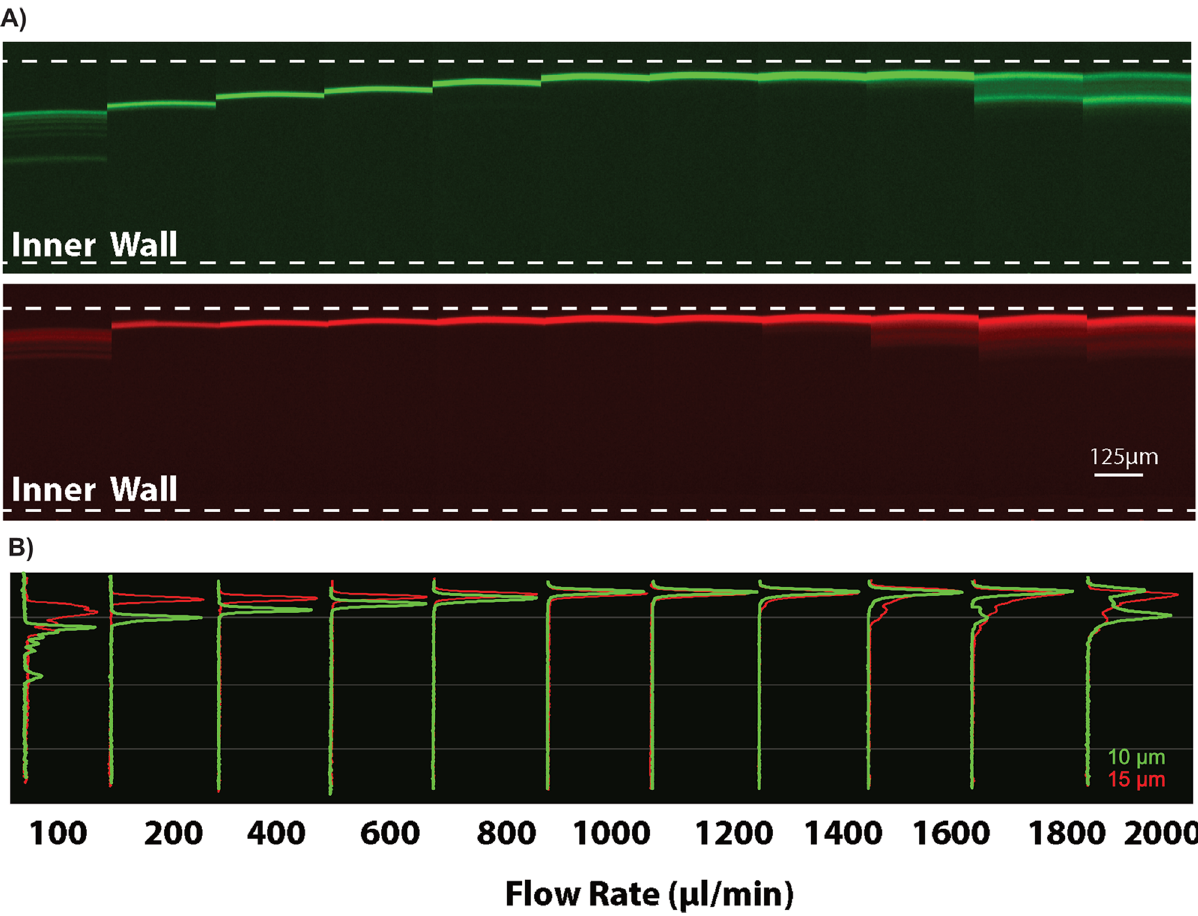
Figure 2. Particle focusing (backward flow direction). ( A ) Fluorescence image of 10 (green) and 15 µm (red) particles at the 5th turn for different flow rates. Stable 3D particle focusing at the outer wall of the spiral microchannel is achieved for a dynamic range of flow rates. Scale bar: 125 µm. ( B ) Corresponding overlapped cross-sectional intensity of the 10 and 15 µm particles. At low flow rates (< 800 μl/min), the larger 15 µm particles are focused closer to the wall and at higher flow rates both the particles are focused at the same lateral